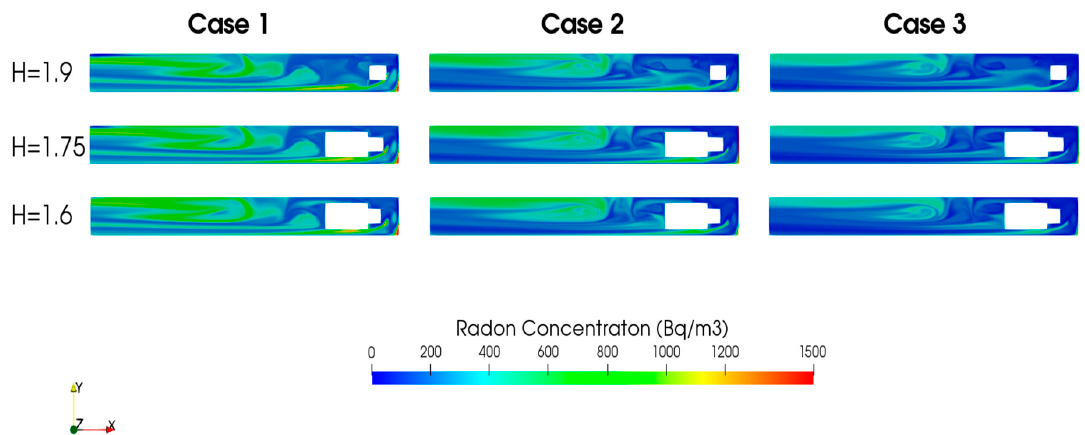
Figure 9. Horizontal cross-sections of radon concentration distribution at different ventilation rates and respirable heights.